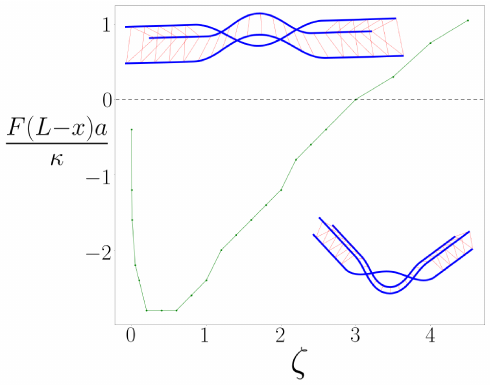
Figure 2. The phase boundary in the parameter space of dimensionless torque (vertical axis) and the 2 dimensionless material parameter ζ = µ a (horizontal axis). The positive values of the torque (above κ the dashed line) correspond to extension, the negative (below the dashed line) to compression. Above the curve, the angle formed by the braid is zero, and below it is non-zero. The pictures represent a straight, or unkinked, braid pair (upper) and a bent, kinked braid pair (lower).